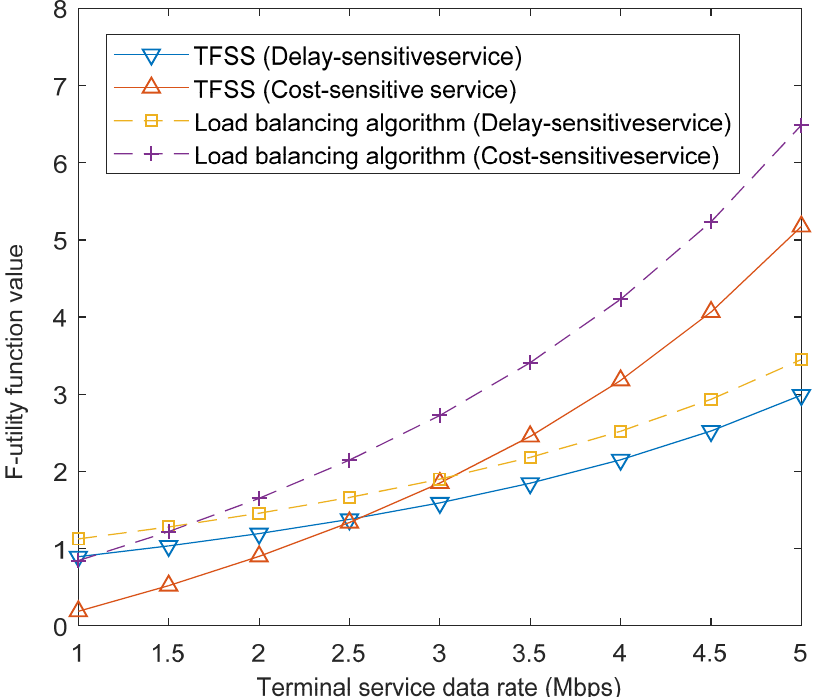
Figure 4. Utility value comparison results.